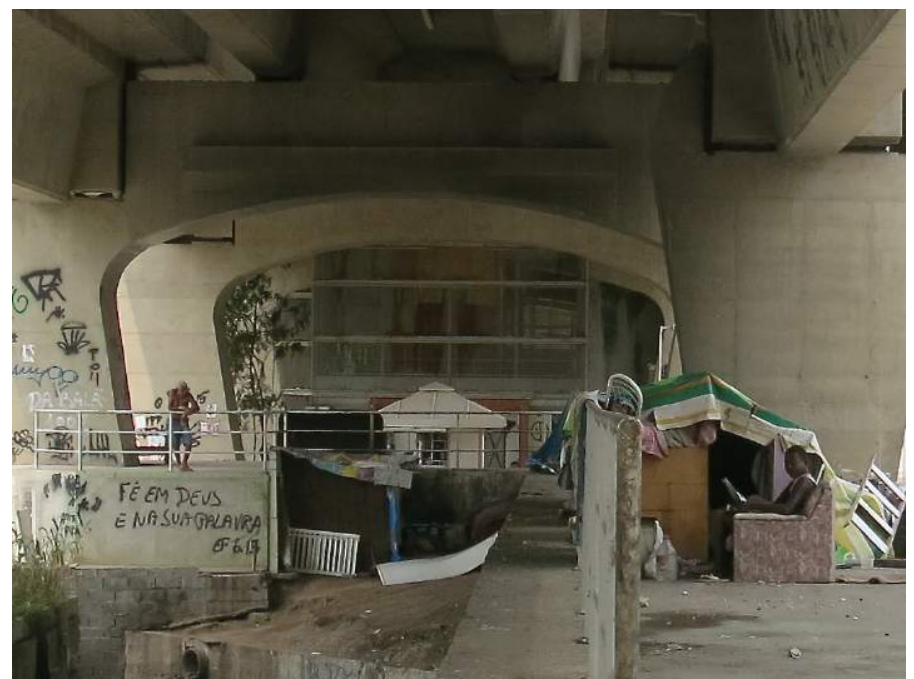
Figure 6. Manguinhos train station under the elevated tracks with river channel/open sewer, 2015.